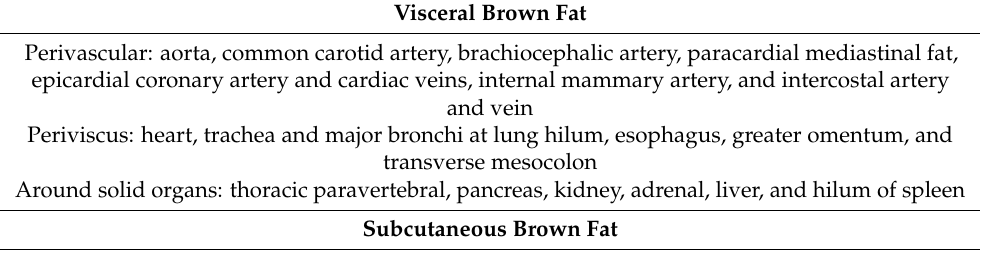
Table 1. Topography of brown adipose tissue. From: [9] (reproduced with permission).